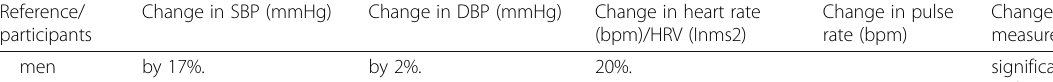
Change in pulse Change in other outcome (bpm)/HRV (Inms2) rate (bpm) measures with walking around a